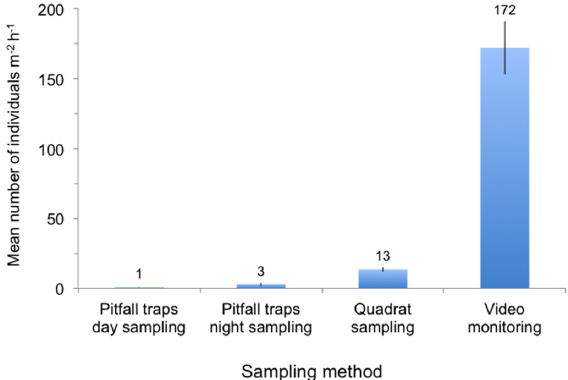
Figure 2. Proportion of arthropod taxa in the four tested moni- toring methods. Means of three measurement dates ( n = 5). Super- scripts in the legend denote statistical differences between the sam- pling methods for each taxon: ∗∗∗ indicates P <0.001; ∗∗ indicates P <0.05; ns indicates P